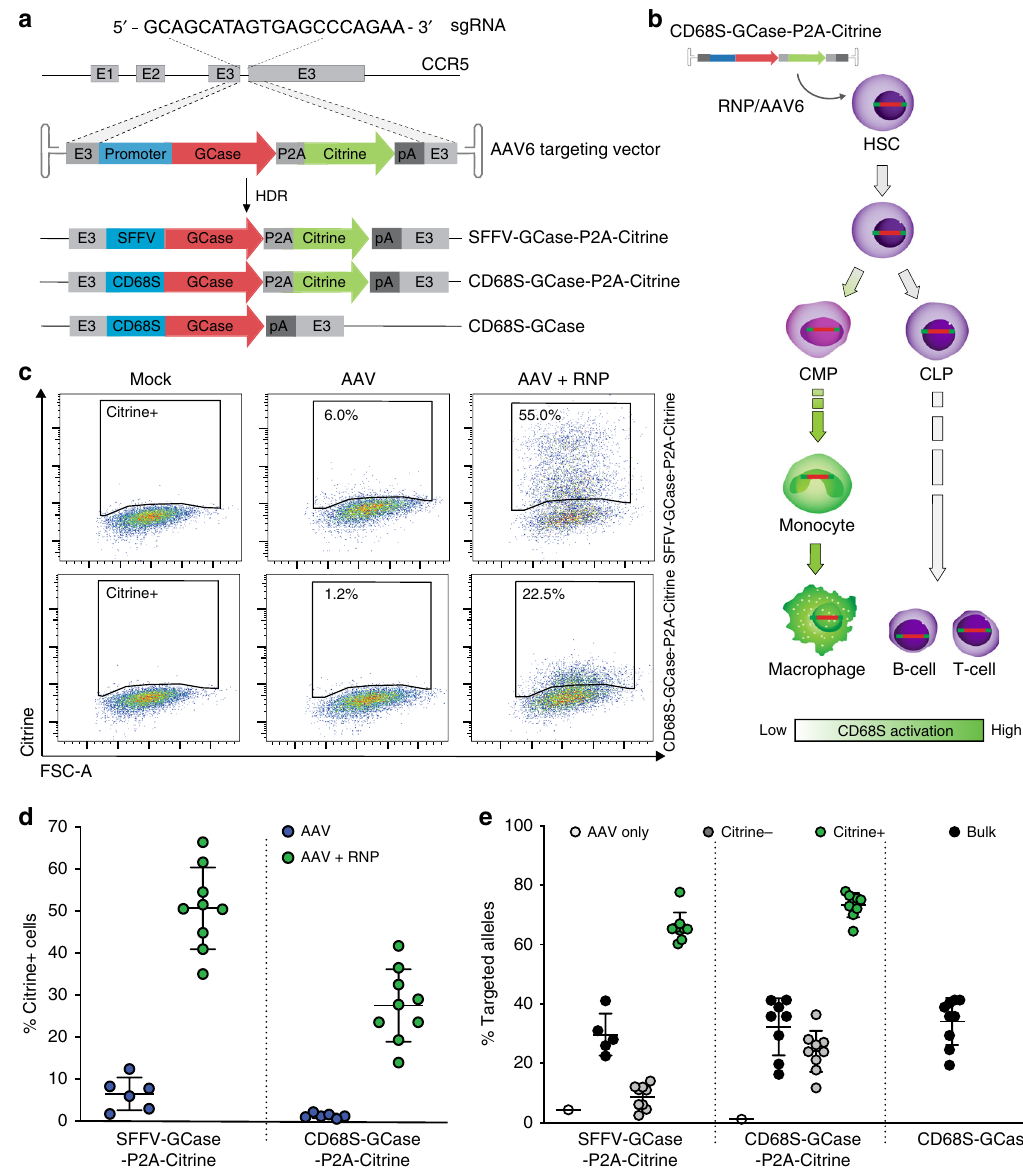
Fig. 1 Ef fi cient targeting of GCase to the CCR5 locus in human HSPCs 48-hours post-modi fi cation. a Schematic of gene targeting mediated by sgRNA/ Cas9 RNP and rAAV targeting vectors where E1-3 are CCR5 exons. b Schematic of expected CD68S promoter activity. Green indicates activation. c Representative fl ow plots of Citrine expression versus forward scatter (FSC) for HSPCs without treatment (mock), treated with rAAV alone (AAV), and treated with RNP and rAAV (RNP + AAV). d Flow cytometric quanti fi cation of Citrine + HSPCs targeted with SFFV-GCase-P2A-Citrine and CD68S-GCase- P2A-Citrine vectors in the presence (green circles) or absence (blue circles) of RNP ( n = 9 biologically independent human donor samples). e Percent of CCR5 alleles with integrated CD68S-GBA-P2A-Citrine and SFFV-GBA-P2A-Citrine cassettes in AAV only (white), bulk (black), FACS-enriched Citrine – (gray) and Citrine + (green) HSPCs, and in bulk CD68S-GCase-targeted cells (black). Data shown as mean ± SD. Source data are provided as a Source Data fi